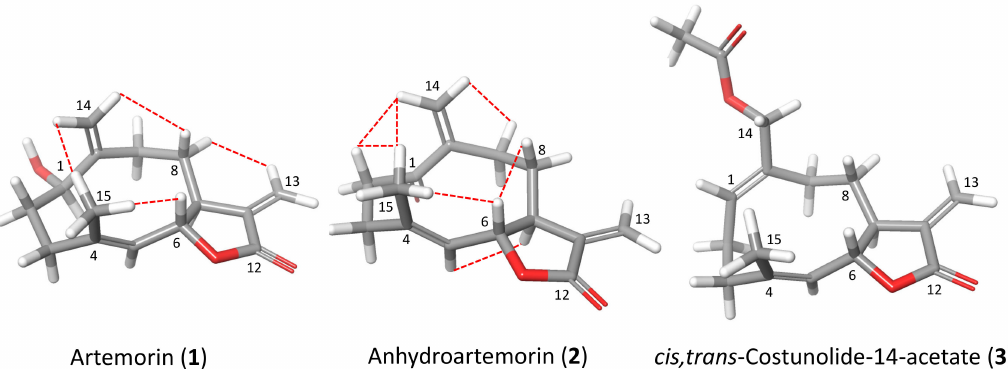
Figure 8. Three-dimensional chemical structure of artemorin ( 1 ), anhydroartemorin ( 2 ) and cis,trans -costunolide-14-acetate ( 3 ). Selected NOE correlations are indicated in dotted red lines for ( 1 ) and ( 2